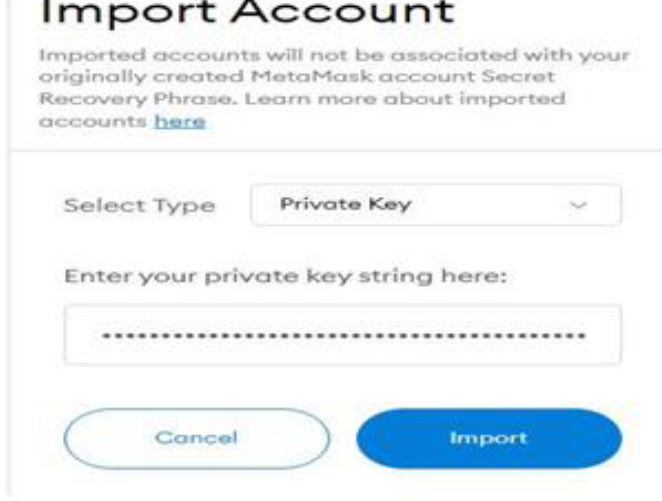
Figure 8. Import account on MetaMask.